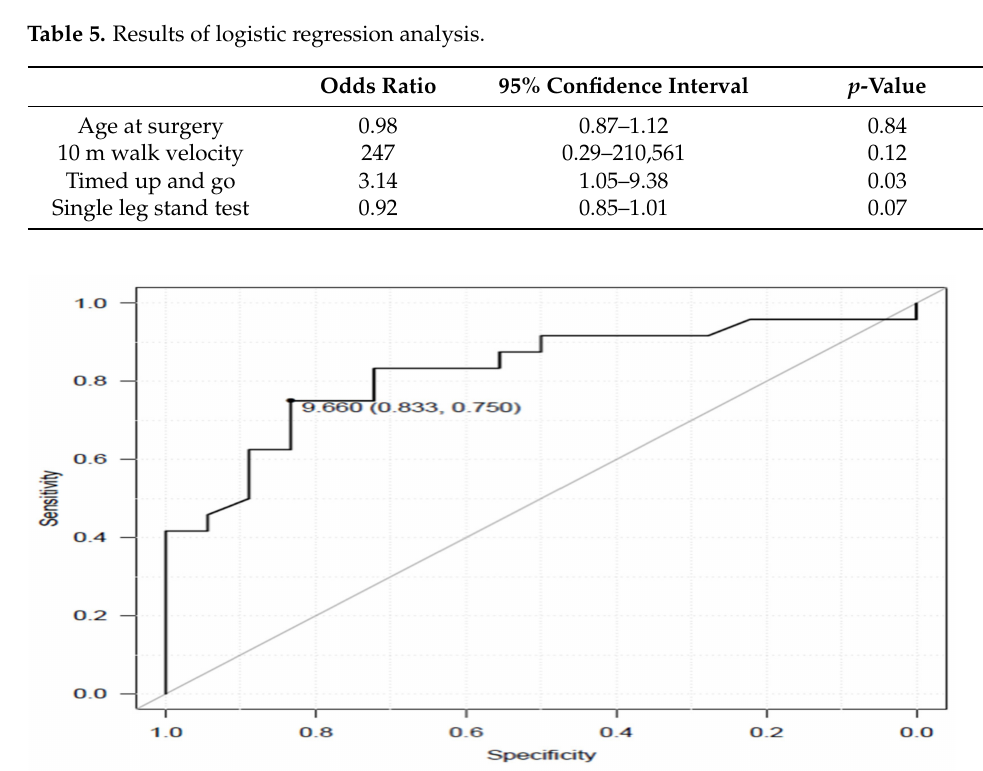
Figure 2. Roc curve of tug for ODI satisfied group and ODI unsatisfied